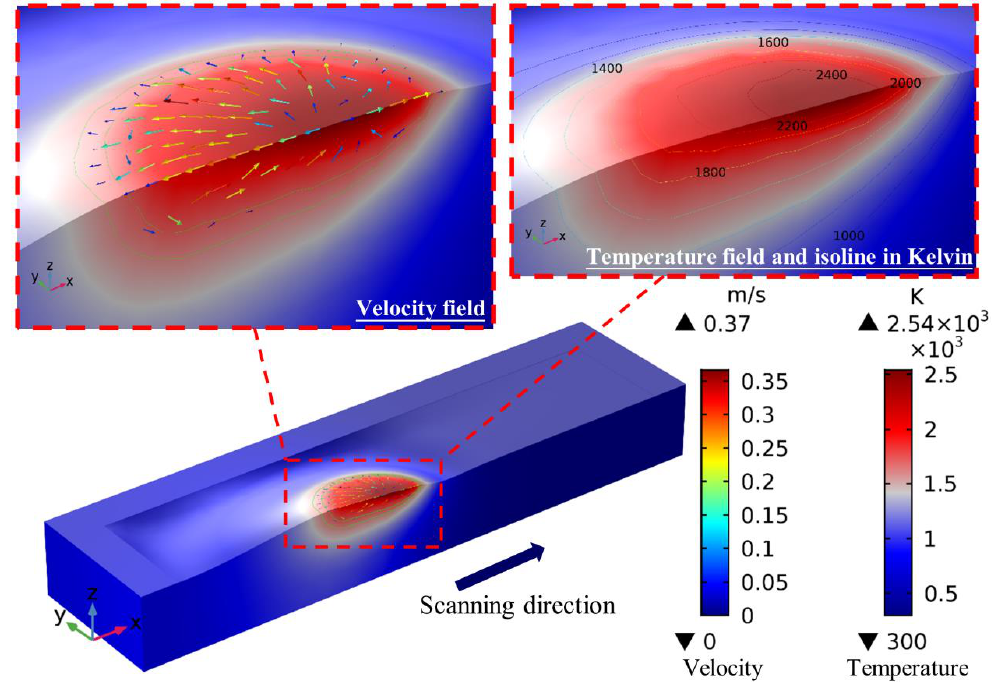
Figure 2. Temperature field and velocity distribution in L-DED of Co-based powders to 38MnVS. The melt pool profile, temperature and velocity distribution at 10 ms, 50 ms, 100 ms